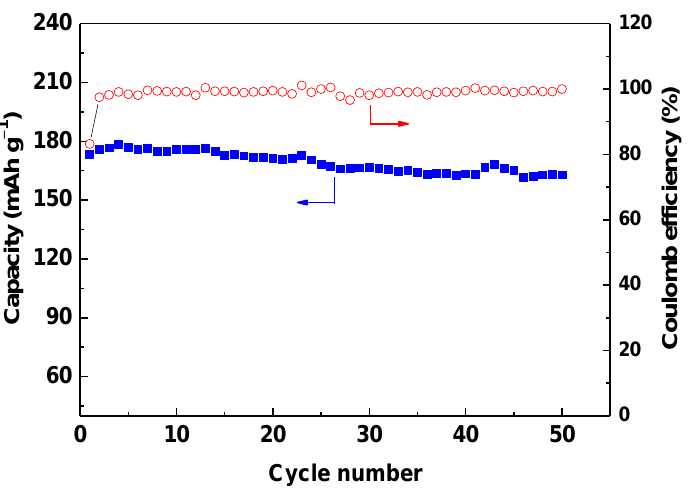
Figure 7. Cycling performance of LiNi 2/3 Co 1/6 Mn 1/6 O 2 calcinated at 800 °C.